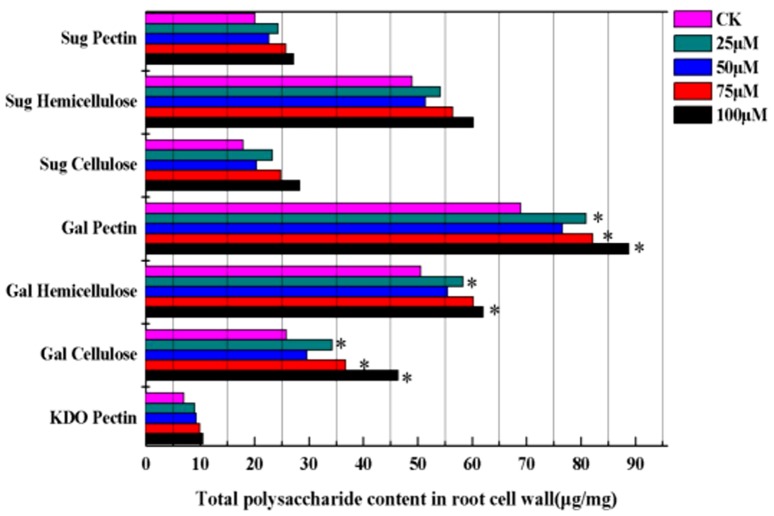
Effect of different copper concentrations on the contents of root cell wall polysacchride.Sug: sugar, Gal: galacturonic acids, KDO: 2-Keto-3-deoxyoctonic acid. Data presented are mean ±SE (n = 3). *Significant mean difference from control at p = 0.05 in multiple comparison by LSD test.